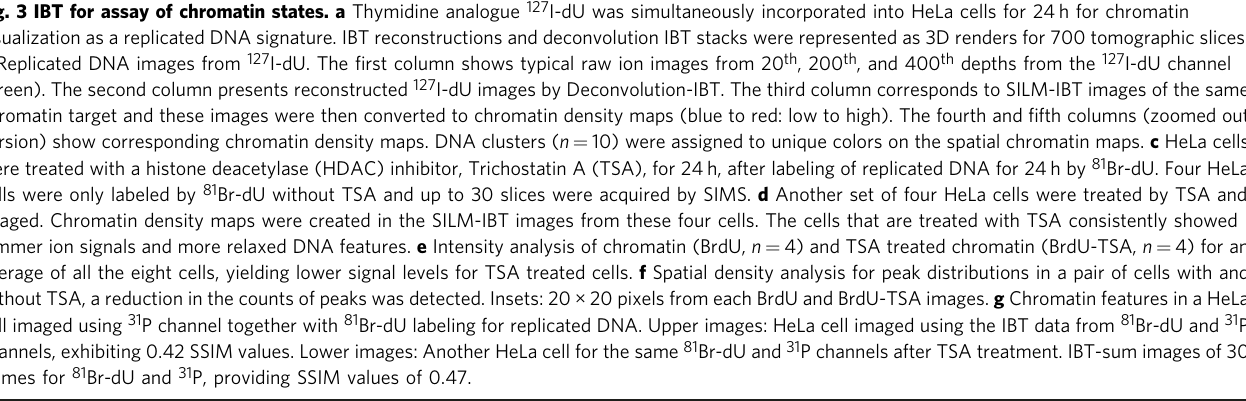
Fig. 3 IBT for assay of chromatin states. a Thymidine analogue 127 I-dU was simultaneously incorporated into HeLa cells for 24 h for chromatin visualization as a replicated DNA signature. IBT reconstructions and deconvolution IBT stacks were represented as 3D renders for 700 tomographic slices. b Replicated DNA images from 127 I-dU. The fi rst column shows typical raw ion images from 20 th , 200 th , and 400 th depths from the 127 I-dU channel (green). The second column presents reconstructed 127 I-dU images by Deconvolution-IBT. The third column corresponds to SILM-IBT images of the same chromatin target and these images were then converted to chromatin density maps (blue to red: low to high). The fourth and fi fth columns (zoomed out version) show corresponding chromatin density maps. DNA clusters ( n = 10) were assigned to unique colors on the spatial chromatin maps. c HeLa cells were treated with a histone deacetylase (HDAC) inhibitor, Trichostatin A (TSA), for 24 h, after labeling of replicated DNA for 24 h by 81 Br-dU. Four HeLa cells were only labeled by 81 Br-dU without TSA and up to 30 slices were acquired by SIMS. d Another set of four HeLa cells were treated by TSA and imaged. Chromatin density maps were created in the SILM-IBT images from these four cells. The cells that are treated with TSA consistently showed dimmer ion signals and more relaxed DNA features. e Intensity analysis of chromatin (BrdU, n = 4) and TSA treated chromatin (BrdU-TSA, n = 4) for an average of all the eight cells, yielding lower signal levels for TSA treated cells. f Spatial density analysis for peak distributions in a pair of cells with and without TSA, a reduction in the counts of peaks was detected. Insets: 20 × 20 pixels from each BrdU and BrdU-TSA images. g Chromatin features in a HeLa cell imaged using 31 P channel together with 81 Br-dU labeling for replicated DNA. Upper images: HeLa cell imaged using the IBT data from 81 Br-dU and 31 P channels, exhibiting 0.42 SSIM values. Lower images: Another HeLa cell for the same 81 Br-dU and 31 P channels after TSA treatment. IBT-sum images of 30 frames for 81 Br-dU and 31 P, providing SSIM values